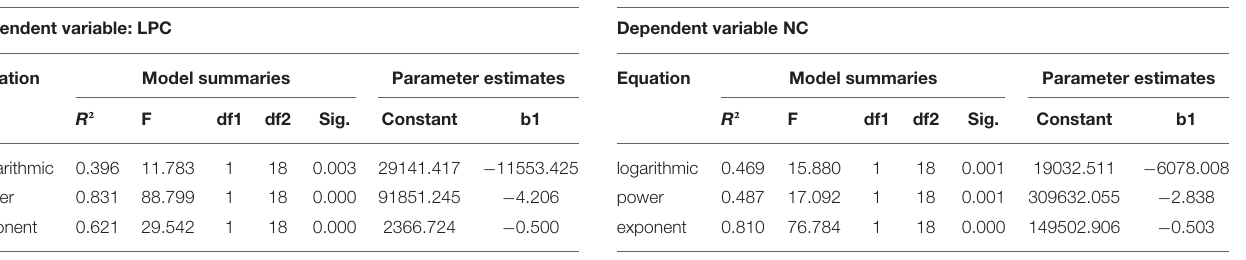
TABLE 5 | Model summaries and parameter estimates of LPC. TABLE 6 | Model summaries and parameter estimates of NC.